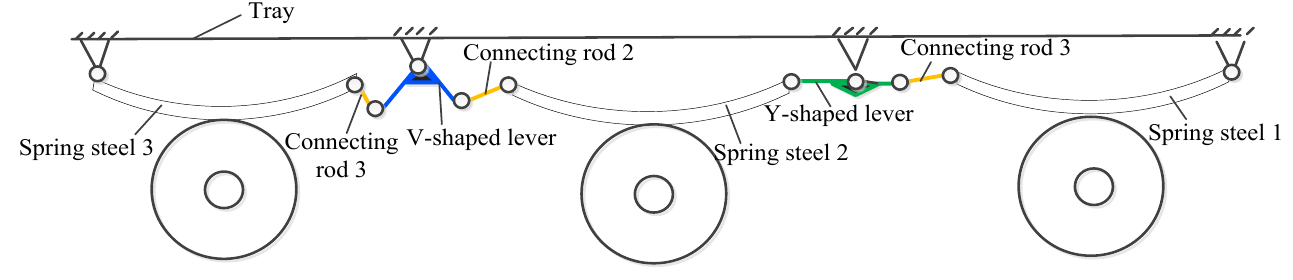
Figure 2. Structure diagram of floating mechanism.